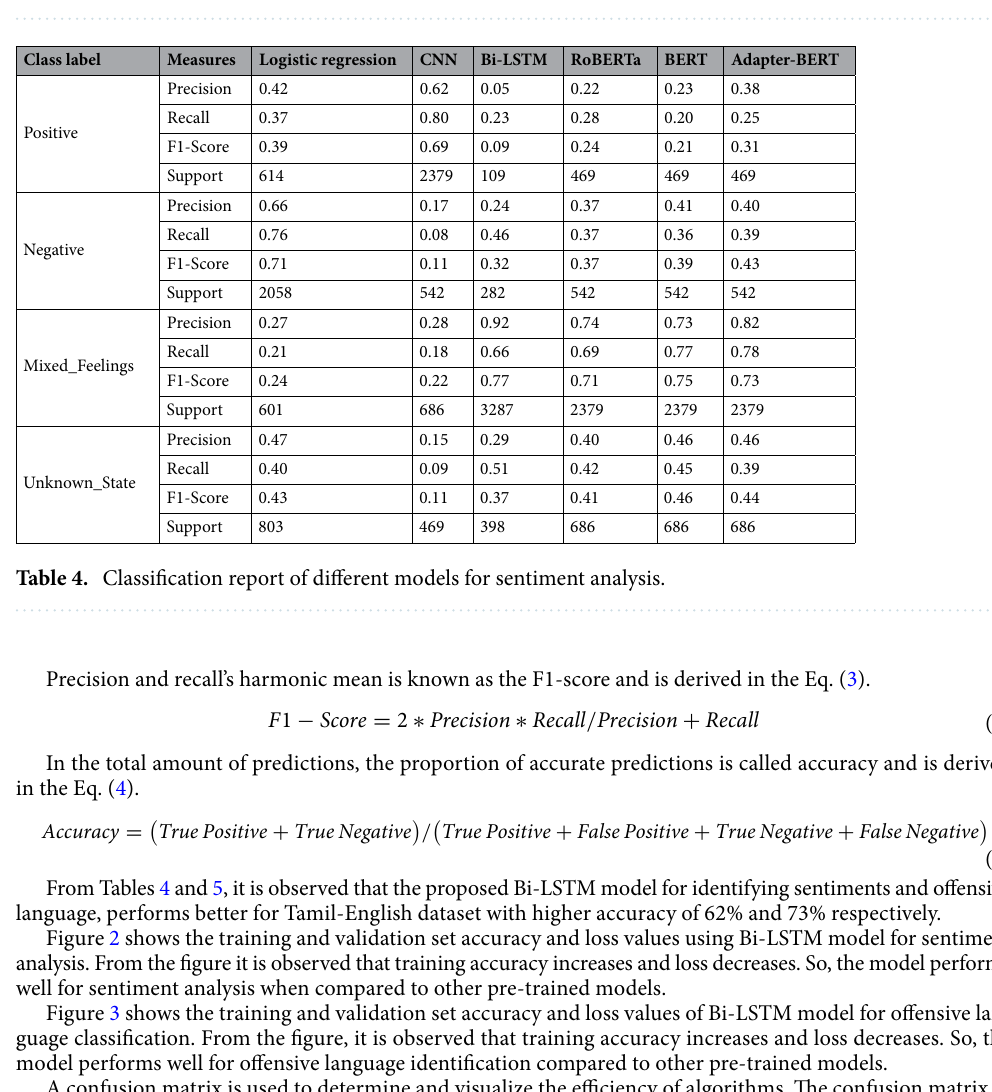
Figure 2. Training and validation accuracy and loss values for sentiment analysis task using adapter-BERT.